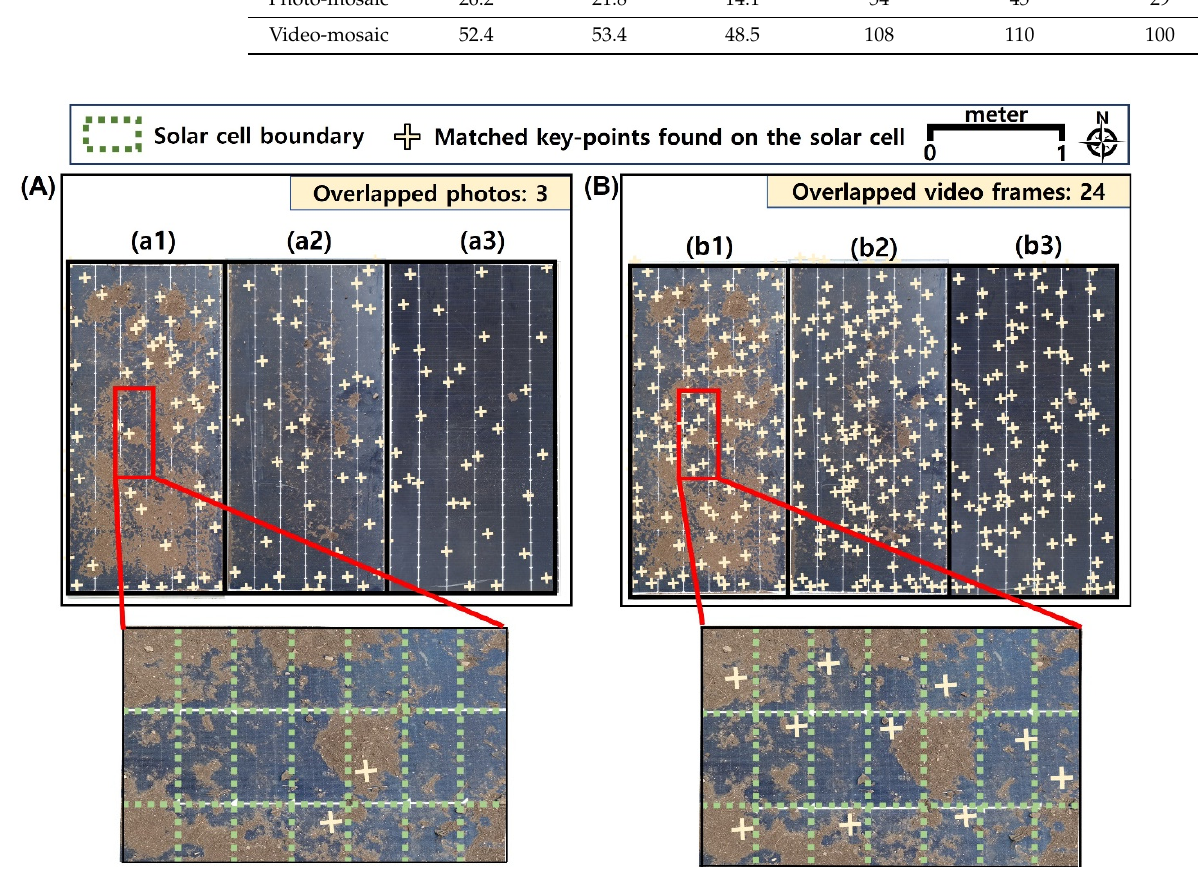
Figure 3. Differentiated distribution density of matched key-points between solar cells of the